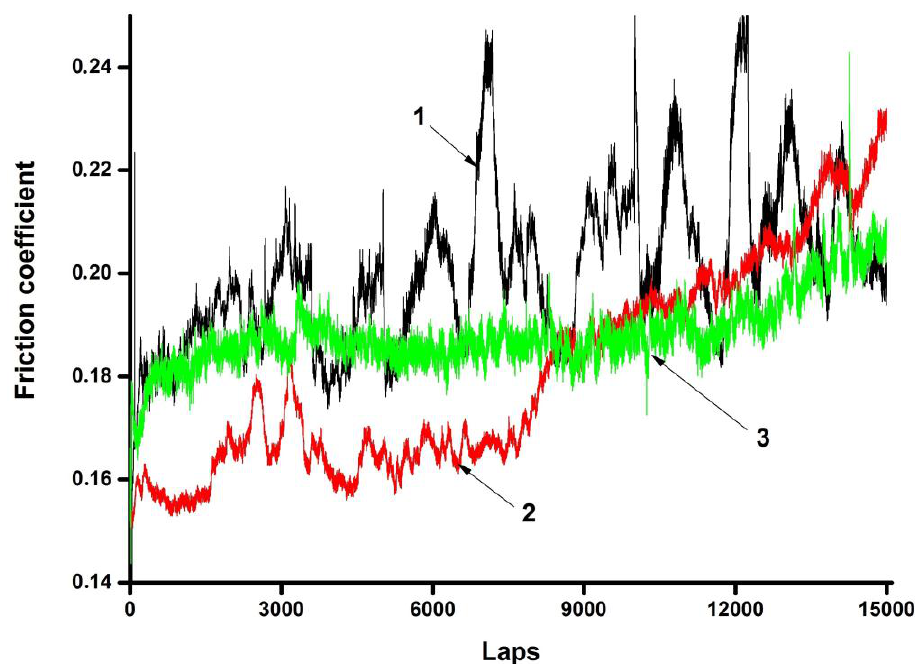
Figure 7. Friction coefficient evolution of Ti-Al-N coatings deposited at I Al : 1–70 A; 2–80 A; 3–90 A.